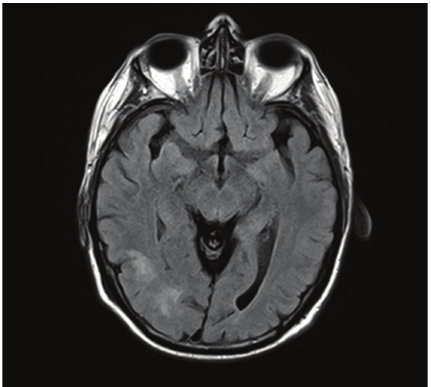
Figure 2: New signal abnormality in the lateral occipital lobe on the right side indicating mild interval progression of the